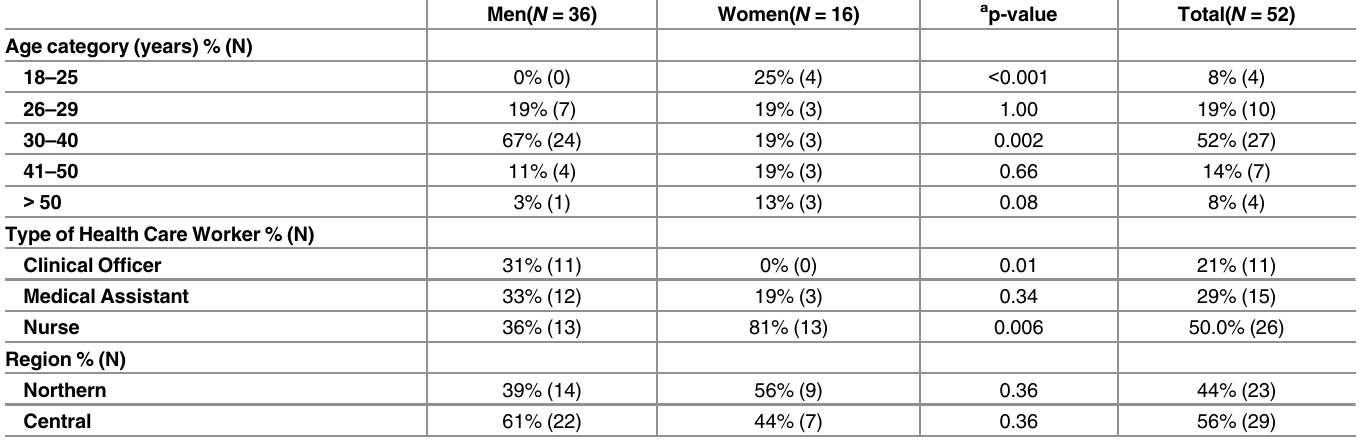
Table 1. Study Population Characteristics Stratified by